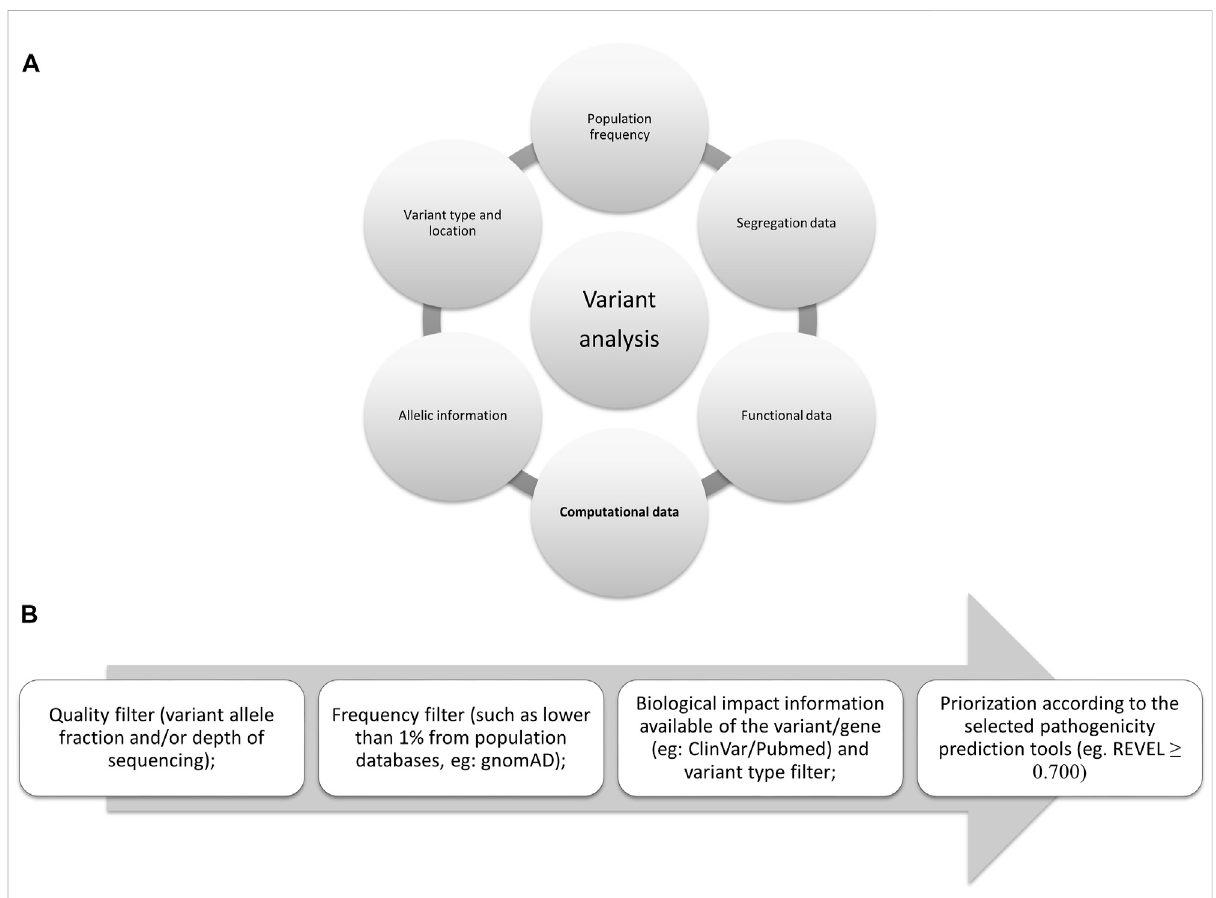
FIGURE 1 Evidences proposed by the international consortiums: (A) Summarized evidence of the criteria proposed by them. (B) Flowchart for fi ltering variants; in silico tools scores may vary, here we present the one proposed by the authors (Ioannidis et al., 2016), although ClinGen suggests higher than 0.800 for oncogenicity (Horak et al.,